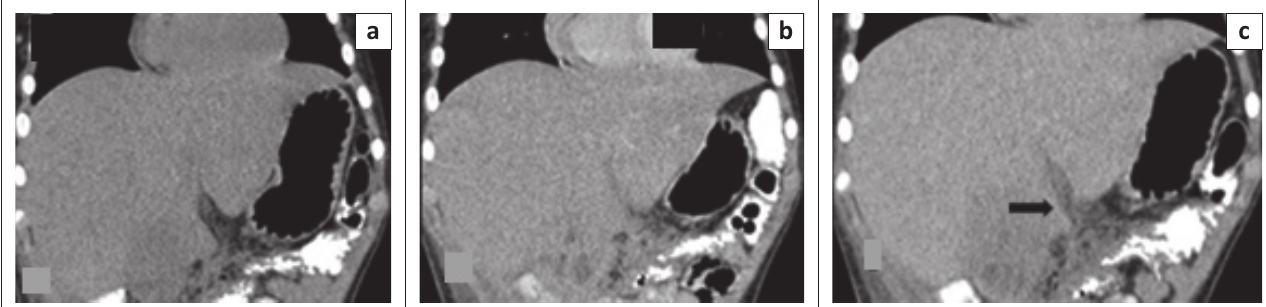
FIGURE 3: A 36-year-old female who presented with a long history of intermittent fever. Coronal computed tomography scan images of an abscess in segment V of the liver (a) precontrast, (b) arterial phase and (c) portovenous phase showing incomplete ring enhancement (arrow).